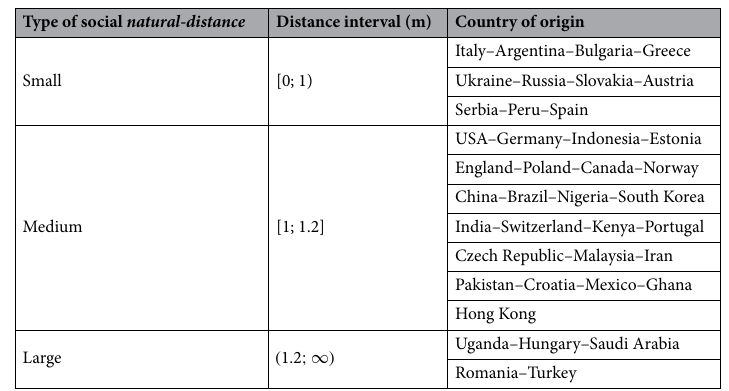
Table 1. Average social natural-distances measured in meters (m) for different countries of origin. (Information was obtained from the article by Sorokowska et al. 19